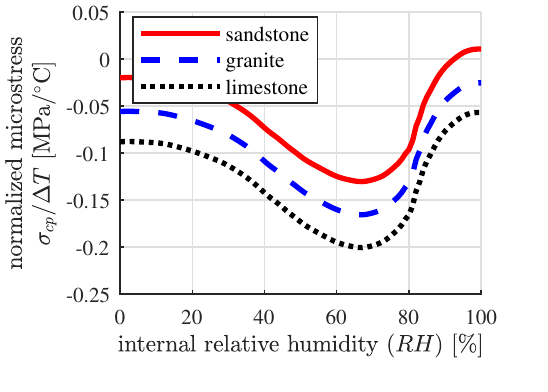
Figure 8. Dependence of the microstresses in ( a ) the cement paste and ( b ) the ITZs, surrounding the coarse aggregates, on the internal relative humidity of concrete containing sandstone, granite and limestone, respectively, as coarse aggregates, with w / c = 0.40, f cp = 0.30 and a ratio of the volume fraction of the coarse aggregates over the total volume of aggregates equal to